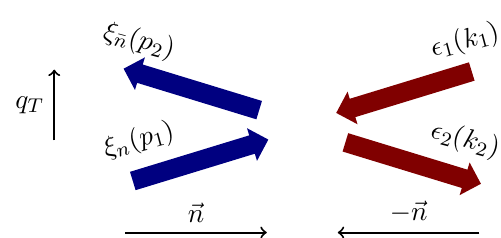
Figure 1 . Quark-gluon scattering at small q T . The incoming quark and outgoing gluon are aligned close to the n µ direction and the incoming gluon and outgoing quark are alighned close to the ¯ n µ